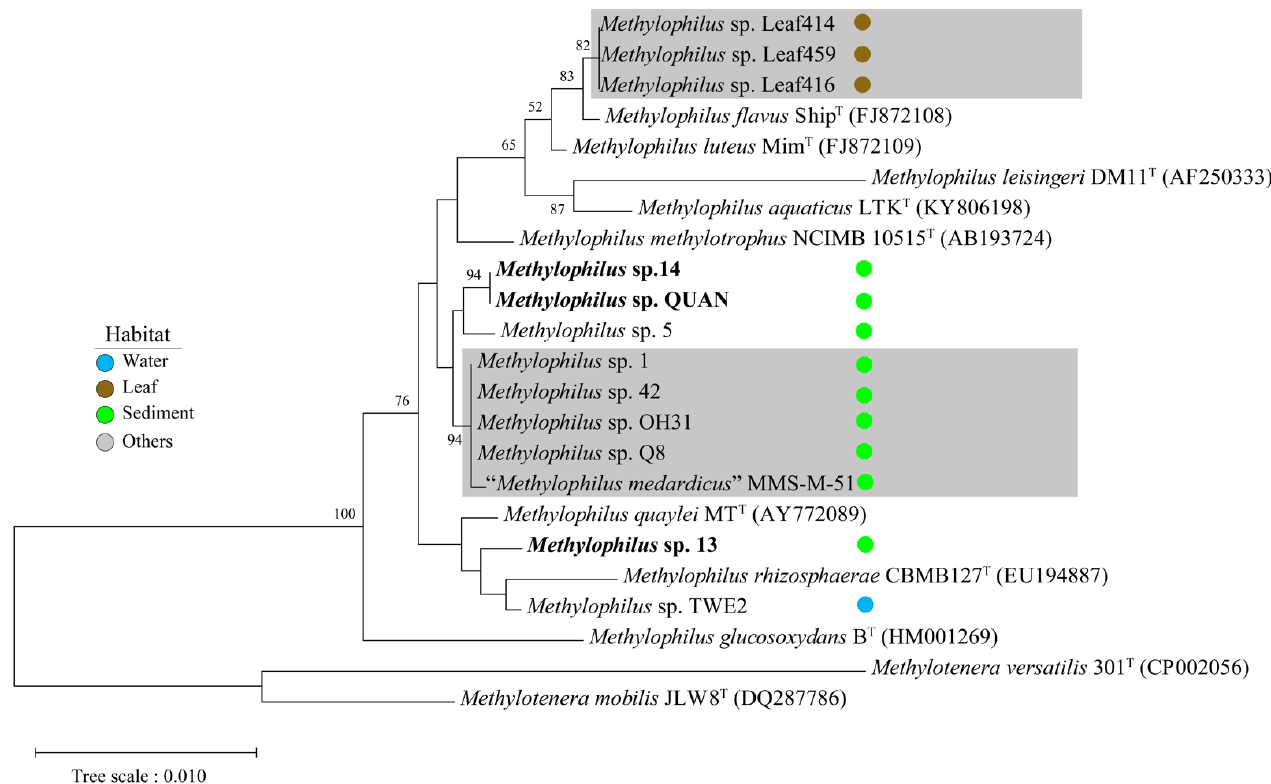
Figure 1. Phylogenomic tree based on 16S rRNA genes. The positions of the 13 strains of genus Methylophilus , 8 Methylophilus type strains and 2 Methylotenera strains were shown in the phylogenomic tree and bootstrap values (the percentage of 1000 data resamplings) ≥ 50% are shown at the nodes based on neighbor-joining method. Three newly isolated methylotrophic strains ( Methylophilus sp. 13, 14 and QUAN) were highlighted with bold. The 16S rRNA gene sequences of Methylotenera versatilis 301 T and Methylotenera mobilis JLW8 T were used as the outgroup. The scale bar represents one substitution per 100 bp. The clades belonging to the same species were highlighted with grey according to AAI results (AAI values larger than 95%), respectively. The solid circles with colors, blue, brown, green and grey, represent isolation sources, water, leaf, sediment and others, respectively. 8 Methylophilus type strains and 2 Methylotenera strains were unlabeled habitat sources. 2 Methylophilus type strains, Methylophilus rhizosphaerae and Methylophilus methylotrophus harbored whole-genome